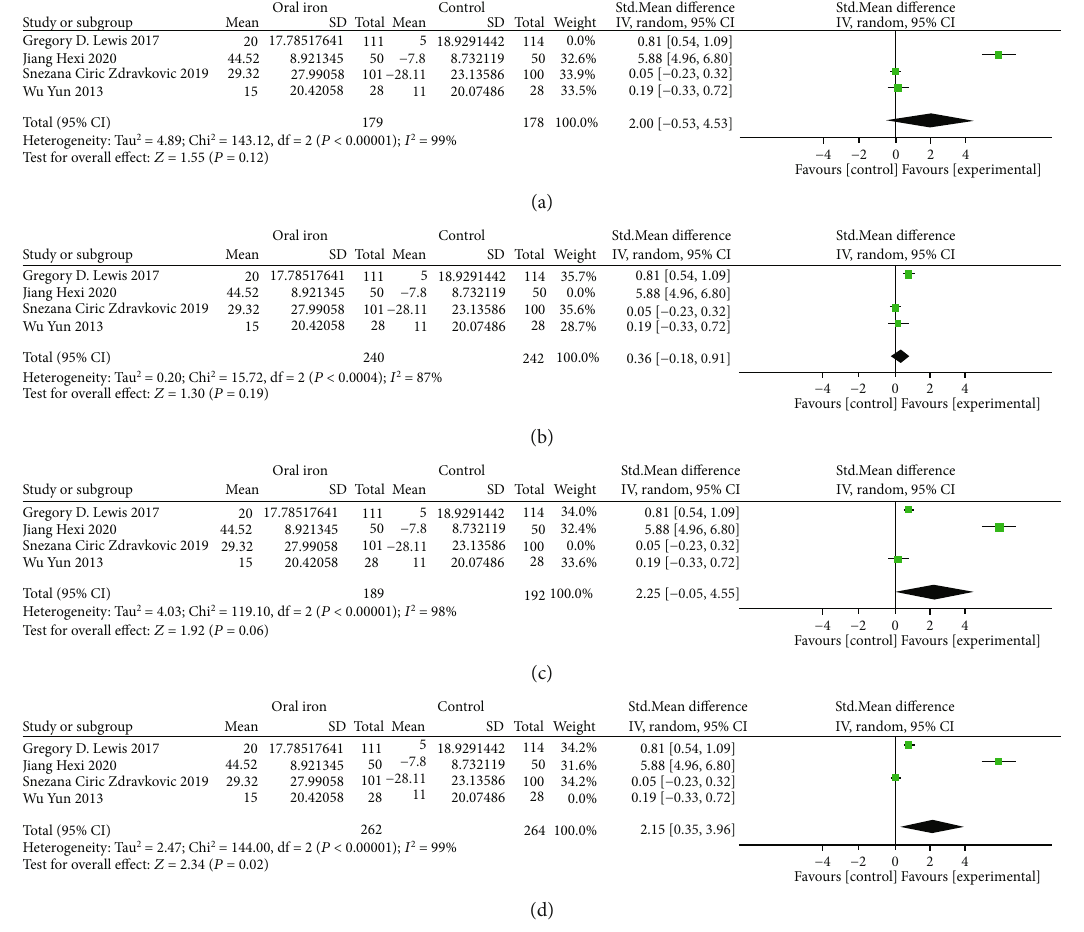
Figure 8: Sensitivity analysis of serum ferritin.